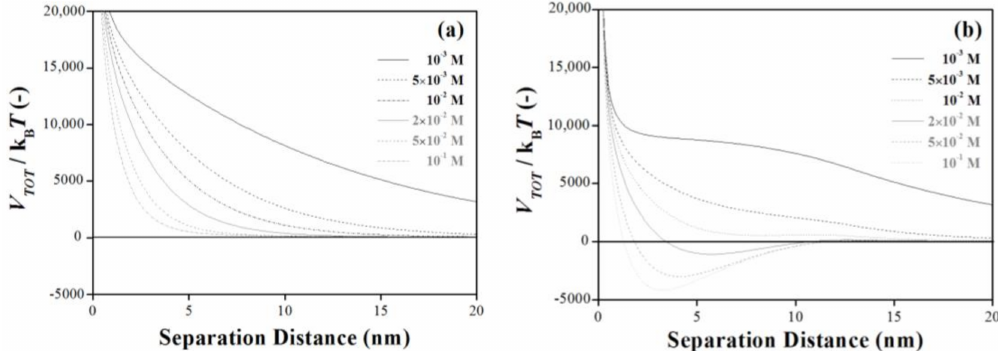
Figure 5. The interaction energy profiles for classical DLVO ( a ) and modified-DLVO including the depletion interaction ( b ) with variations in the ionic strengths (10 − 3 –10 − 1 M) are represented as a function of the separation distance, respectively. The values of the silica-bubble-water Hamaker constant ( − 3.12 × 10 − 21 J), silica surface potential ( − 0.02 V at pH 7), bubble surface potential ( − 0.025 V at pH 7), polymer weight (10 wt %), polymer volume fraction (8.84 × 10 − 1 ( v / v )), polymer radius of gyration (6.48 × 10 − 9 m) and polymer molecular weights (10 4 g/mol) are